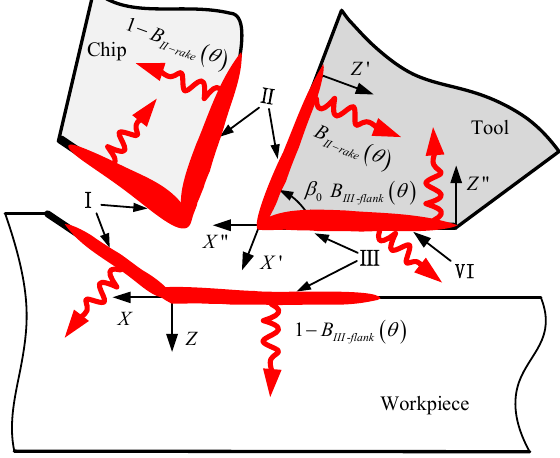
Figure 2. Four heat sources and heat distribution systems.